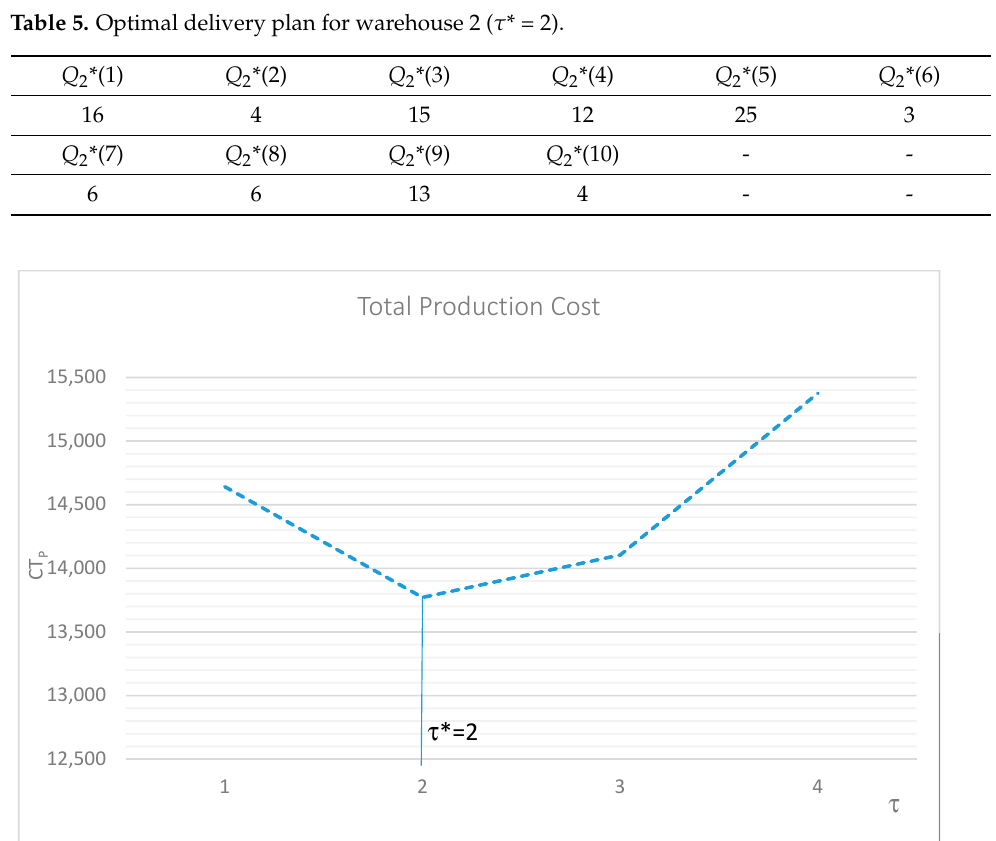
Table 6. Average demand of customer 1.